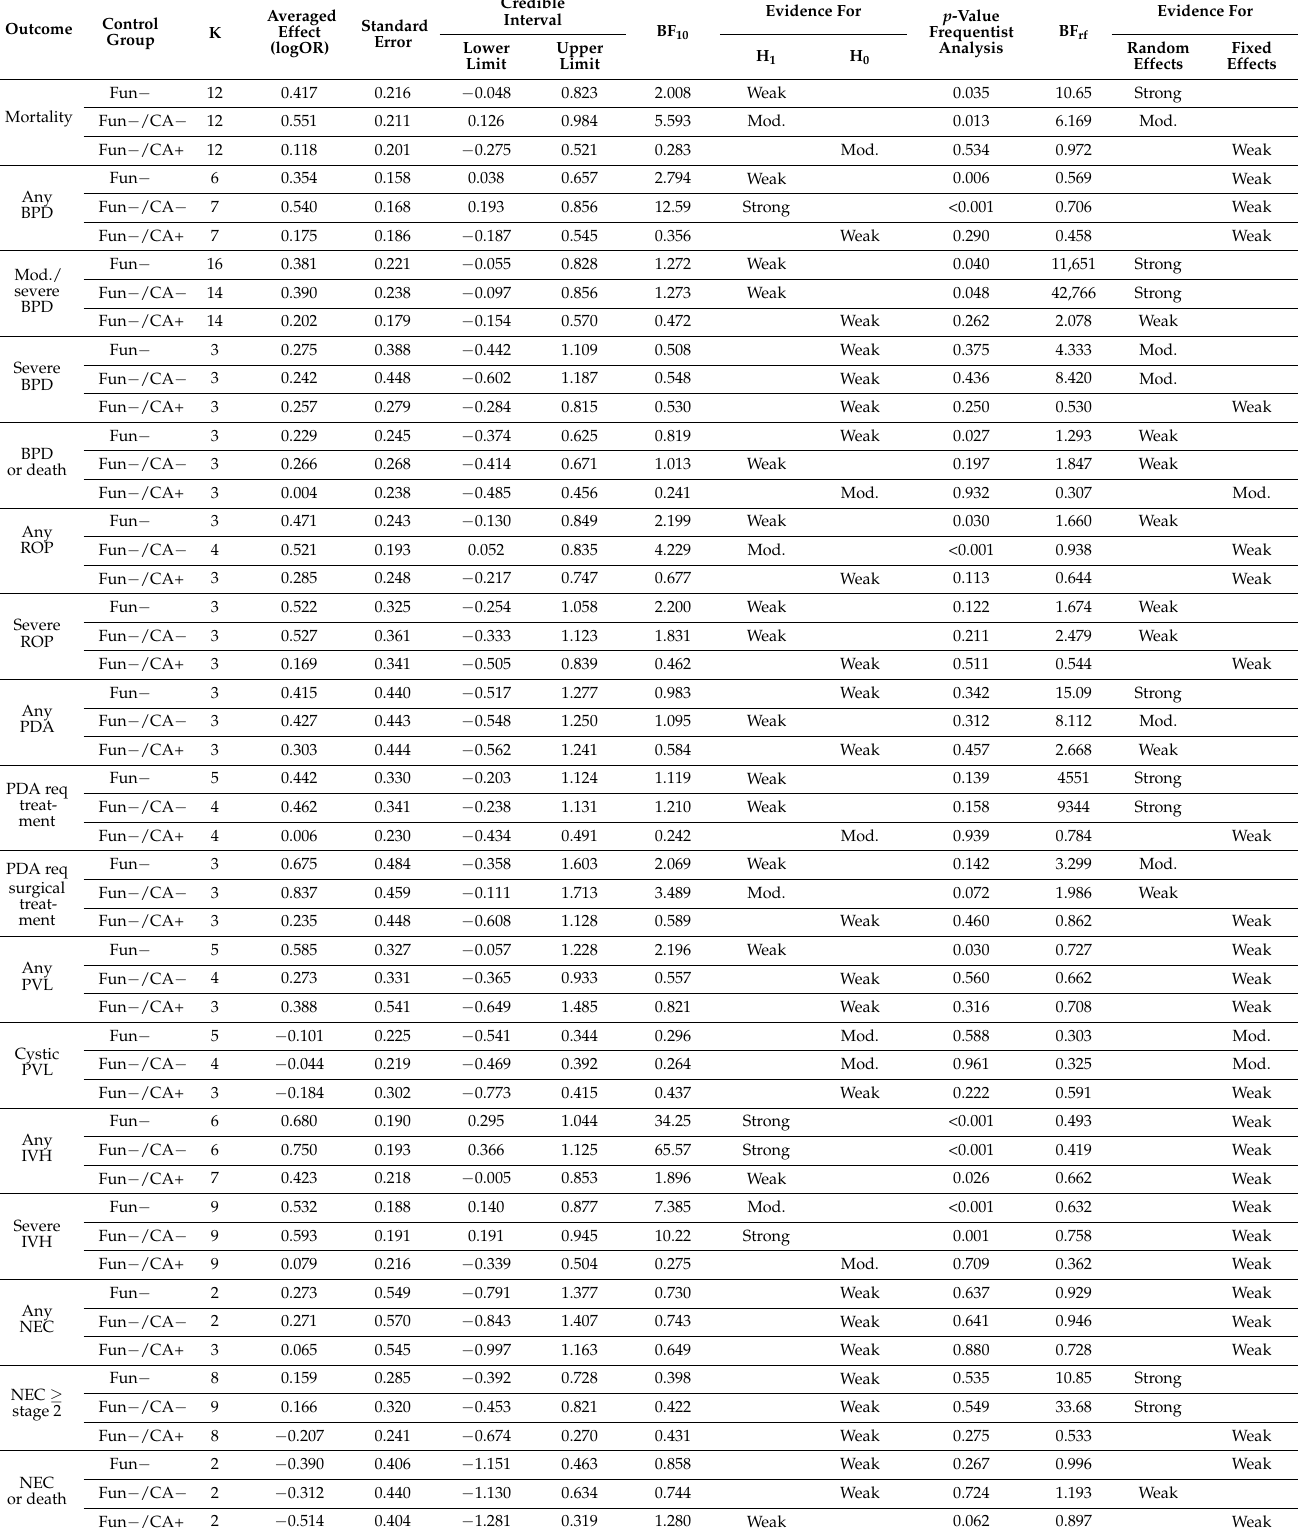
Table 1. Bayesian model average (BMA) meta-analysis of the association between funisitis and outcomes of